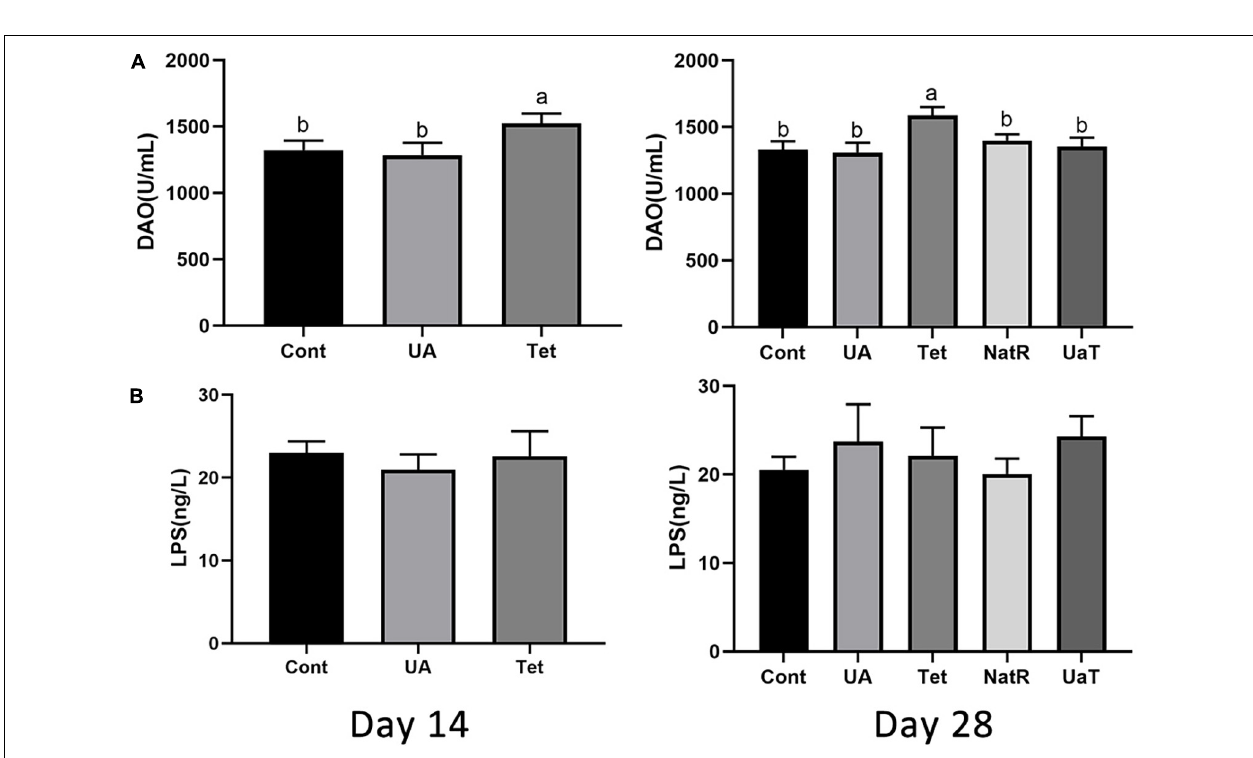
FIGURE 3 | Administration of ursolic acid mitigates antibiotic-induced gut barrier dysfunction. Levels of DAO (A) and LPS (B) in the serum of mice. All group names correspond to those described in the legend of Figure 2 . Data are shown as means ± standard deviations. Statistically significance results between each treatment group on days 14 and 28 were expressed by lowercase letters (a, b, c) based on ANOVA with Duncan’s range tests. Mean values with different letters indicate statistically significance results ( P < 0.05). n = 6 mice per group.